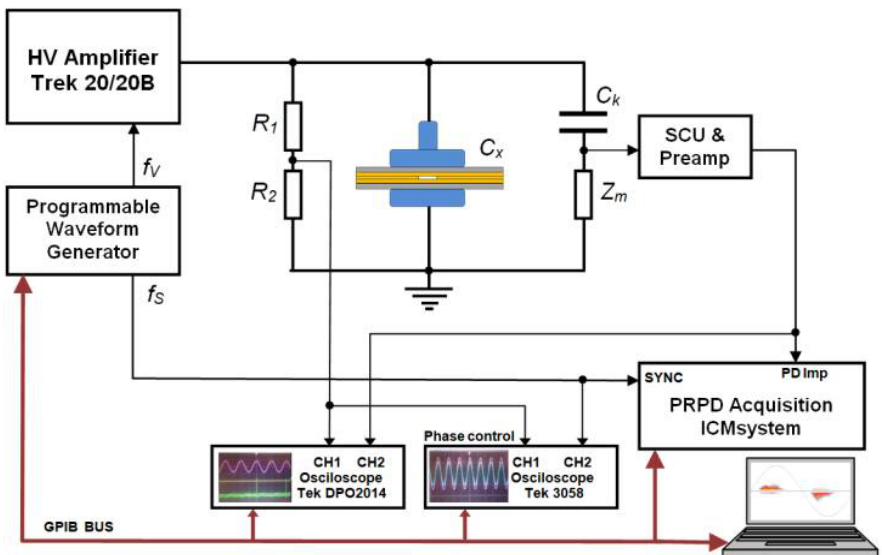
Figure 2. Measuring setup for PD measurements of DC voltage with superimposed harmonics: C x — test object, Z m —coupling impedance, C k — coupling capacitor, R 1 , R 2 —resistive divider, SCU —signal conditioning unit and preamplifier [29].